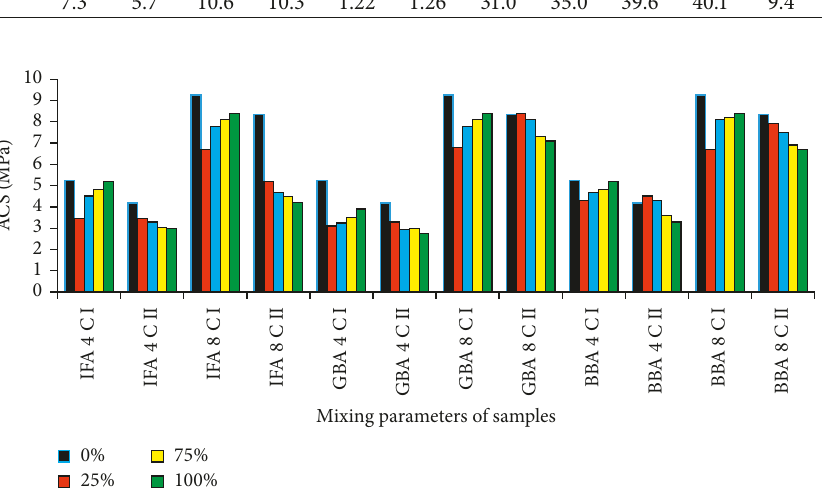
Figure 5: Relationship of ACS of the samples having different admixtures. IFA: ˙Isken FA; 4: BC40; 8: BC80; C: CEM; GBA: G¨oknur BA; BBA: Bor